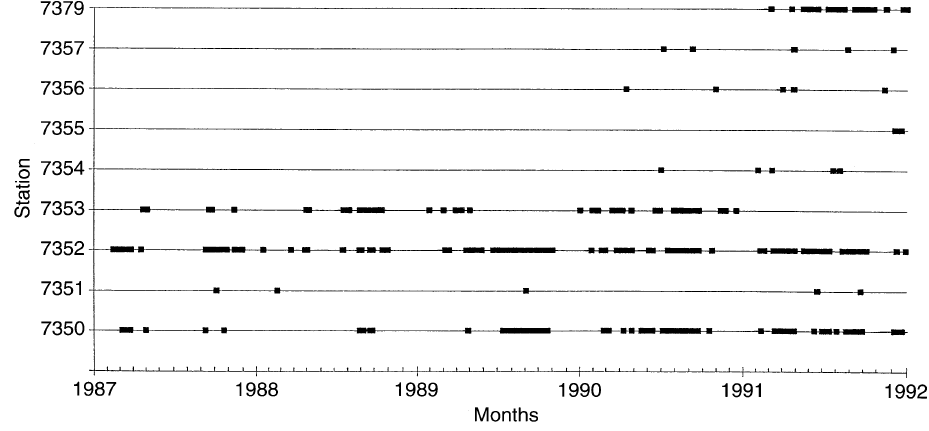
atmosphere. Data from radiosoundings and remote sens- ing will have to be included in the analysis. Table 3 shows monthly average pressure values, standard deviations and the number of cases from which average values were computed. June, July, August and September values for station 7356 are missing, due to insufficient availability of measurements. The constantly lower pressures at station 7379 are due to insufficient accuracy in the altitude and/or pressure measurements. A linear relation holds between annual pressure averages (hPa) and height (m); the best fit is: p ( h ) "! 0.1126 * h # 984.6794